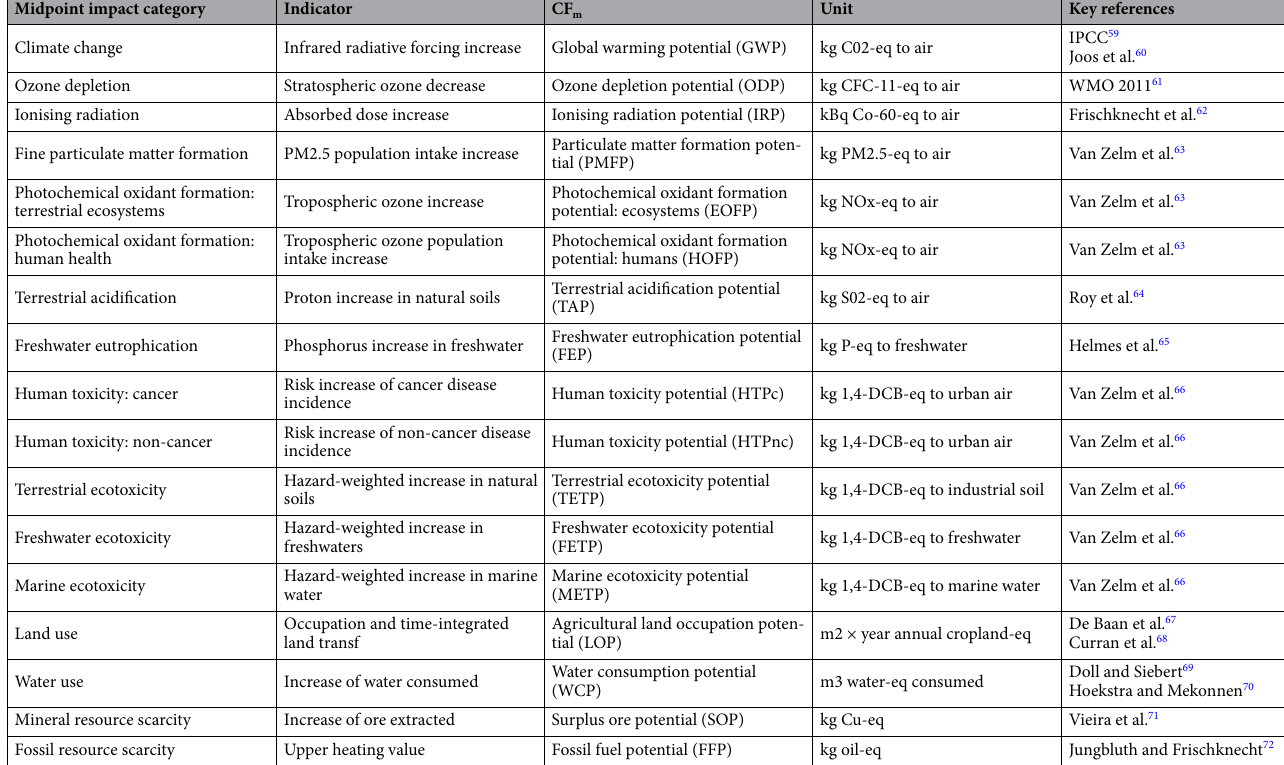
Table 3. Overview of the midpoint impact categories and related indicators 58